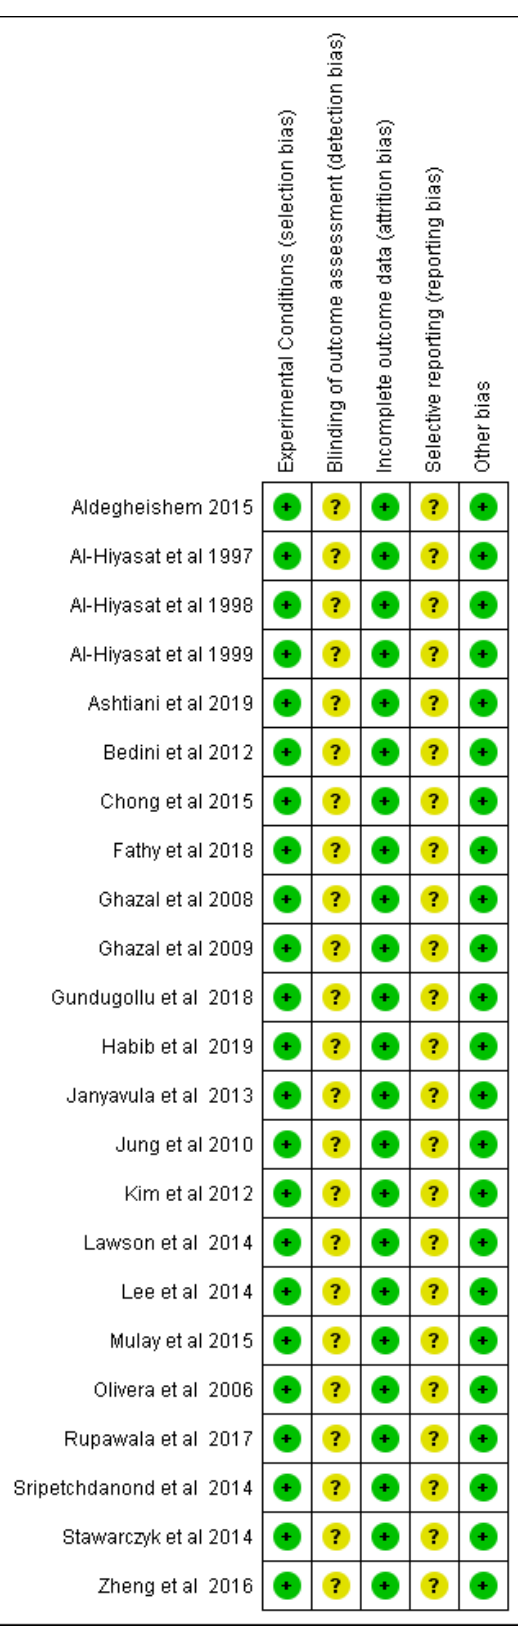
Figure 2. Risk of bias summary outlining judgment of risk of bias items for each of the included in vitro studies (n = 23). The plus sign indicates low risk of bias; the circle with a question mark indicates an unclear risk of